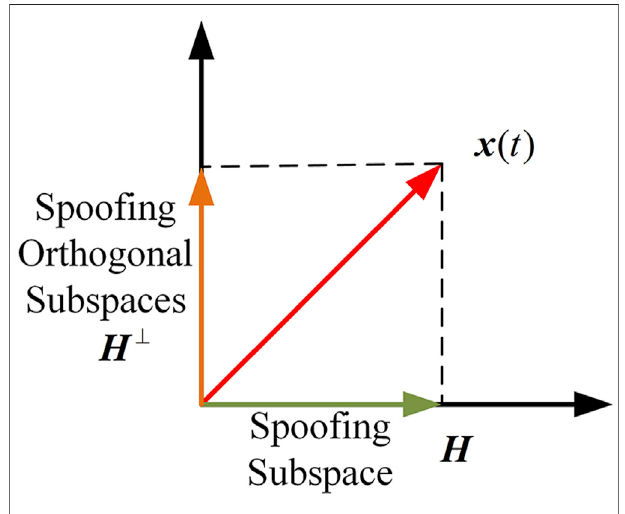
FIGURE 5 | Schematic diagram of the principle of subspace projection.